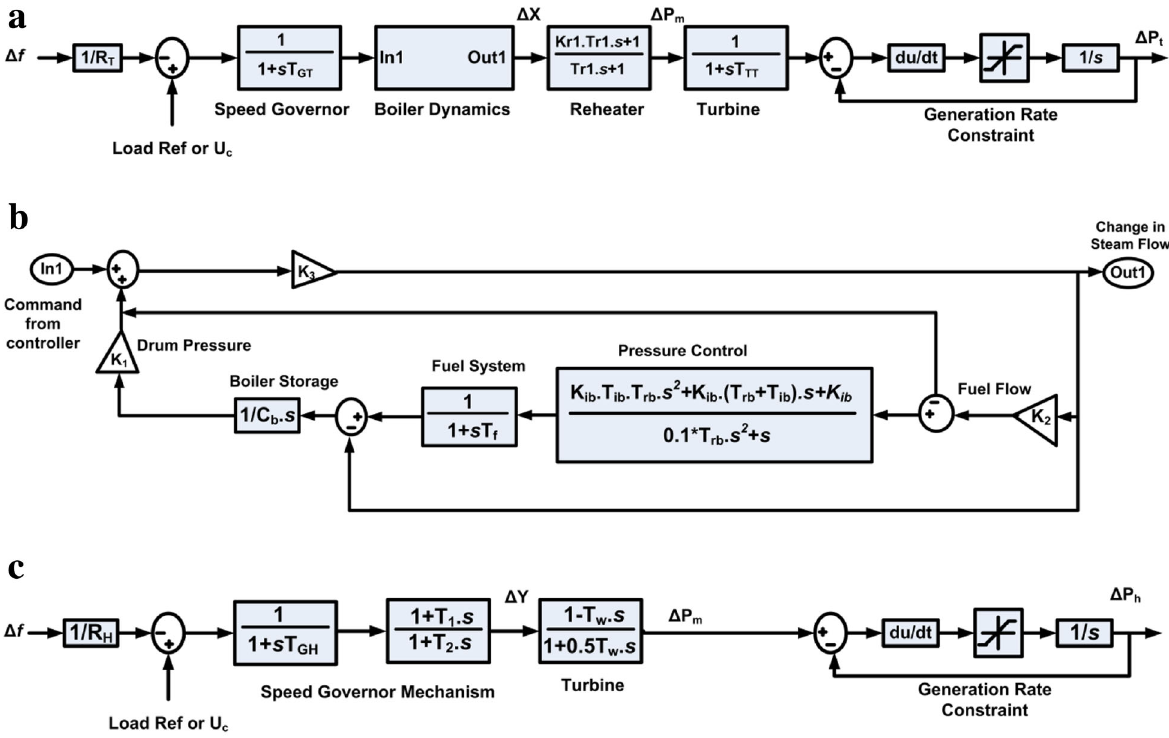
Fig. 2 Mathematical model of a thermal unit, b boiler dynamics and c Hydro unit